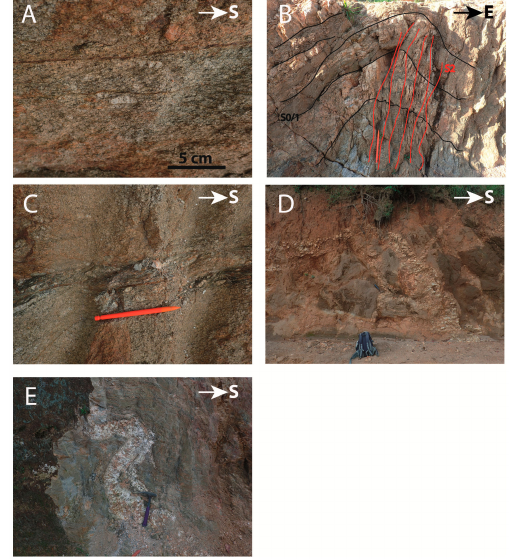
Figure 2. Features and structures affecting the gneissic host rocks of the Gakara REE mineralization. See text for details. ( A , C , D ) Gasagwe mine road; ( B ) FK and garnet-rich para-gneisses hosting the Kiyenzi REE occurrences. The pegmatites parallel to S0/S1 are folded and schistosed by S2; ( E ) pegmatite and host gneiss, the fold affects both the pegmatite and a previous foliation (main road to